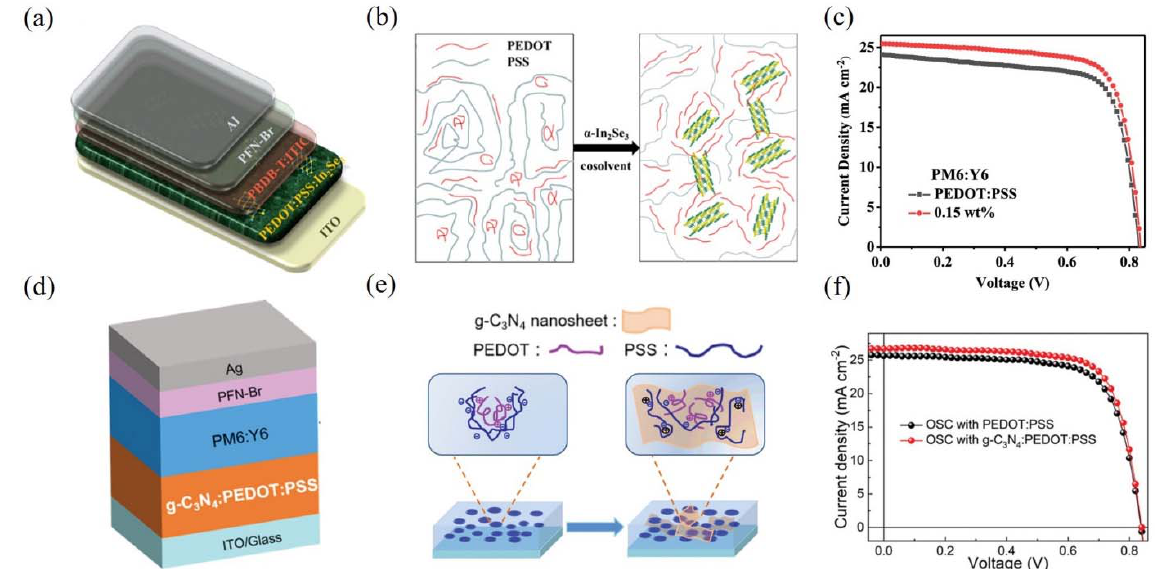
Figure 7. Schematic diagram of ( a ) the device architecture and ( b ) the mechanism of the conductivity enhancement; ( c ) J-V curves of the control devices and the devices with the addition of 0.15 wt% α -In 2 Se 3 . Reprinted with permission form [90]. Copyright 2020 American Chemical Society. Schematic diagram of ( d ) the device structure and ( e ) compositional changes of PEDOT:PSS before and after the doping of g-C 3 N 4 ; ( f ) J-V curves of OSCs with g-C 3 N 4 :PEDOT:PSS as HTL. Reprinted with permission form [27]. Copyright 2020 John Wiley and Sons.